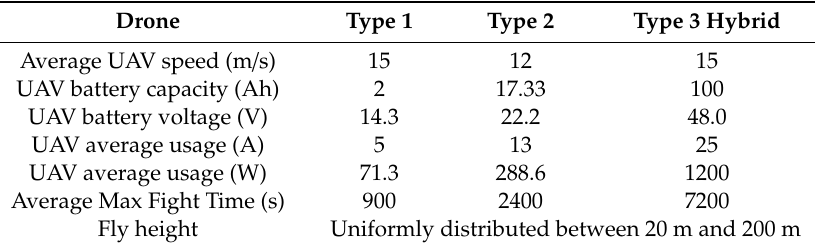
Table 3. Drone specification for